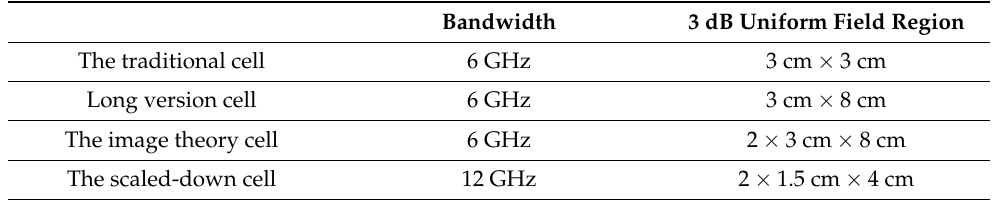
Table 4. Comparison of the